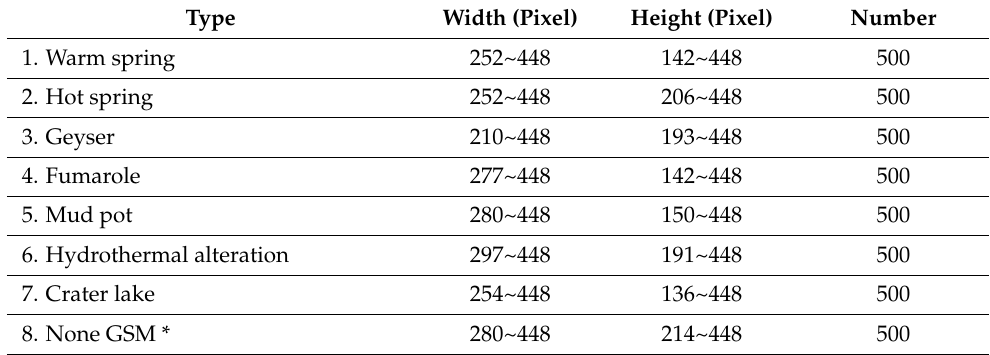
Table 1. The size variation and number of the eight types of geothermal surface manifestations. Type Width (Pixel) Height (Pixel)